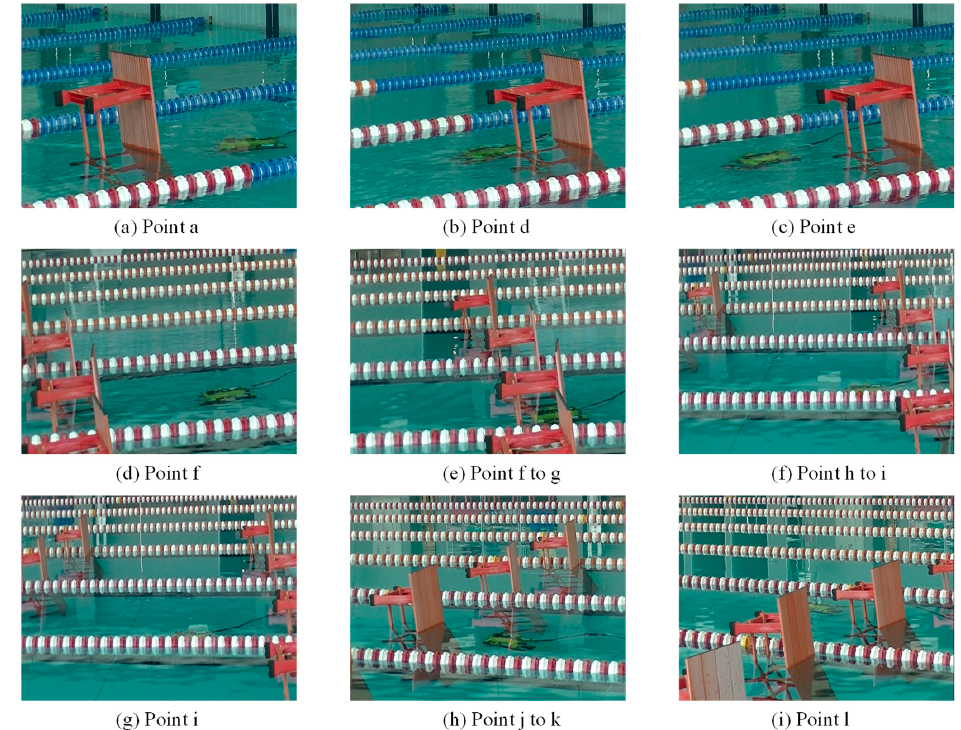
Figure 15. Side view images of the experiment.